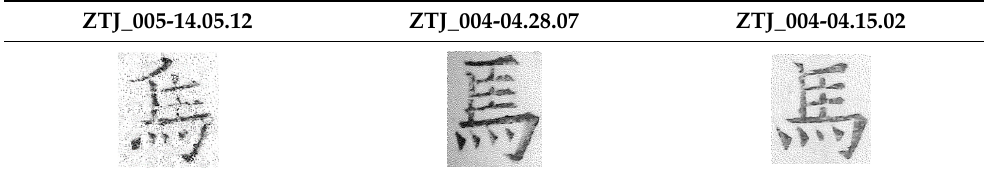
Table 2. Examples of the characters w¯u 烏 , y¯an 焉 , and mˇa 馬 in the Goryeo edition of the ZTJ . Table 2. Examples of the characters w ū 烏 , y ā n 焉 , and m ǎ 馬 in the Goryeo edition of the ZTJ . Table 2. Examples of the characters w ū 烏 , y ā n 焉 , and m ǎ 馬 in the Goryeo edition of the ZTJ . Table 2. Examples of the characters w ū 烏 , y ā n 焉 , and m ǎ 馬 in the Goryeo edition of the ZTJ